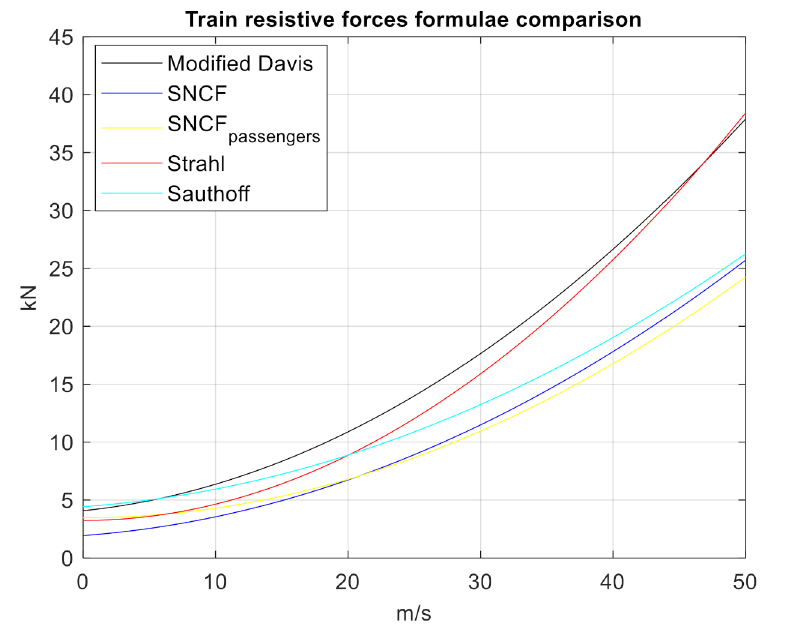
Figure 1. Train friction forces obtained through different